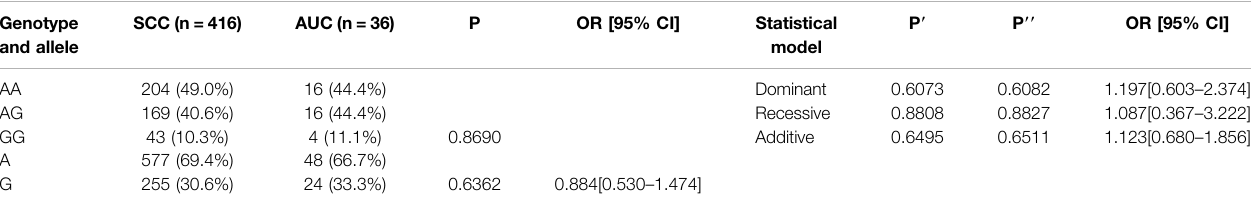
TABLE 5 | Comparison of genotypes and allele distribution frequencies between the SCC group and AUC group. Genotype and